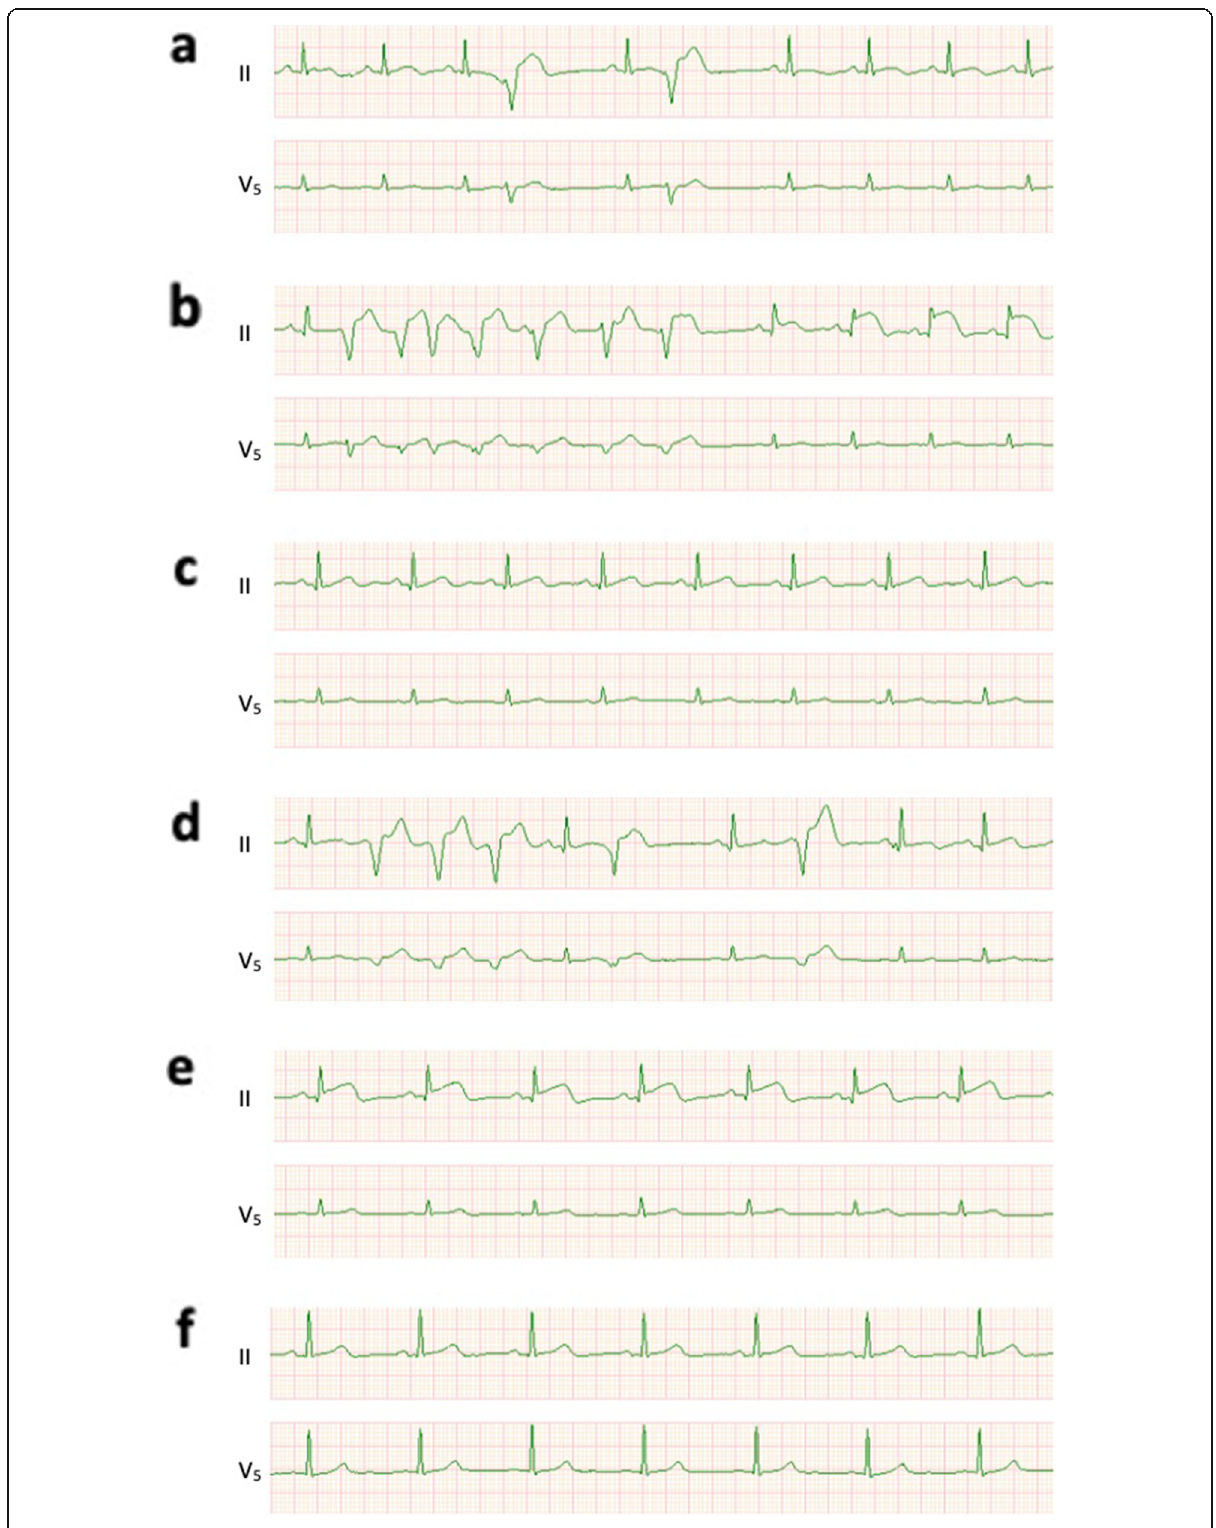
Fig. 1 (See legend on next